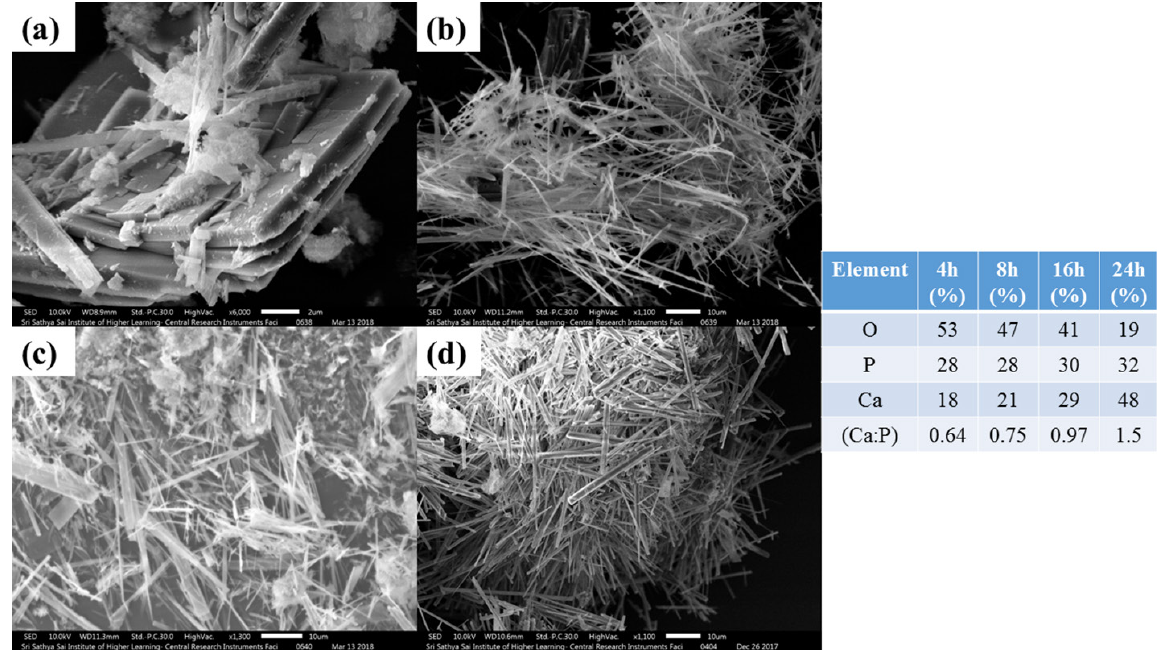
Figure S3: S3 SEM images and corresponding EDX report of the composition of the nano-hydroxyapatite for the temperature profile of hydrothermal synthesis at 10 µ m resolution